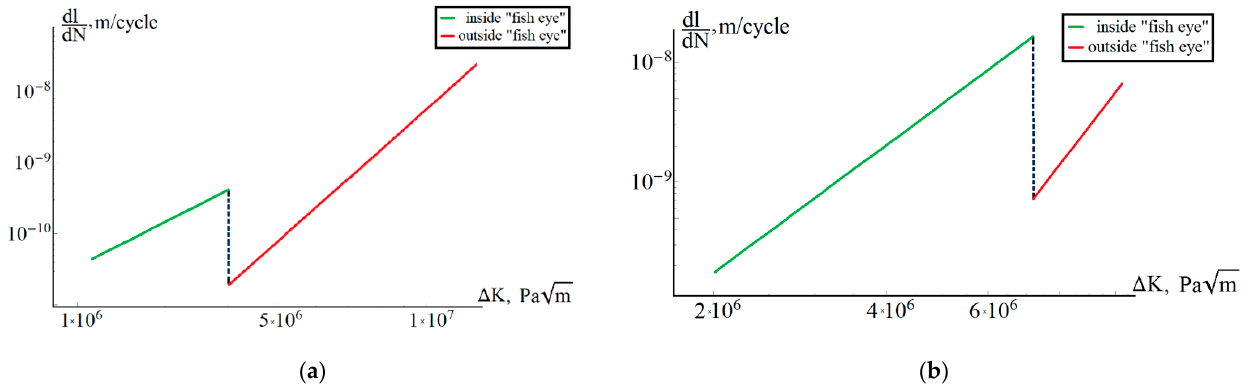
Figure 9. ( a ) Kinetic diagram for sample No. 1. ( b ) Kinetic diagram for sample No. 2.